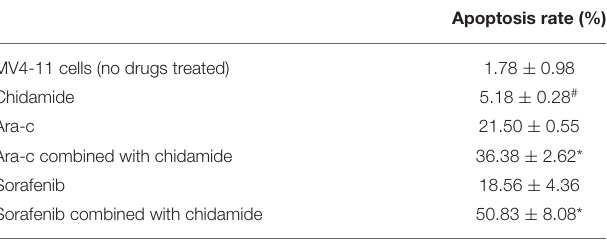
TABLE 4 | The change in the apoptosis of MV4-11 cell lines treated by chidamide, Ara-c, sorafenib, and Ara-c combined with chidamide and sorafenib combined with